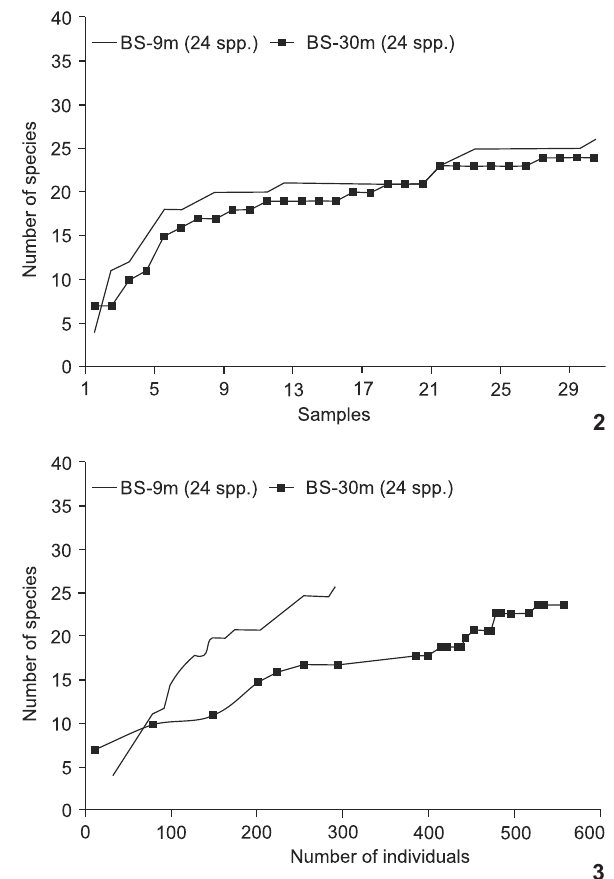
Figures 2-3. Curve of cumulative number of species by the num- ber of samples captured (2), and the number of individuals